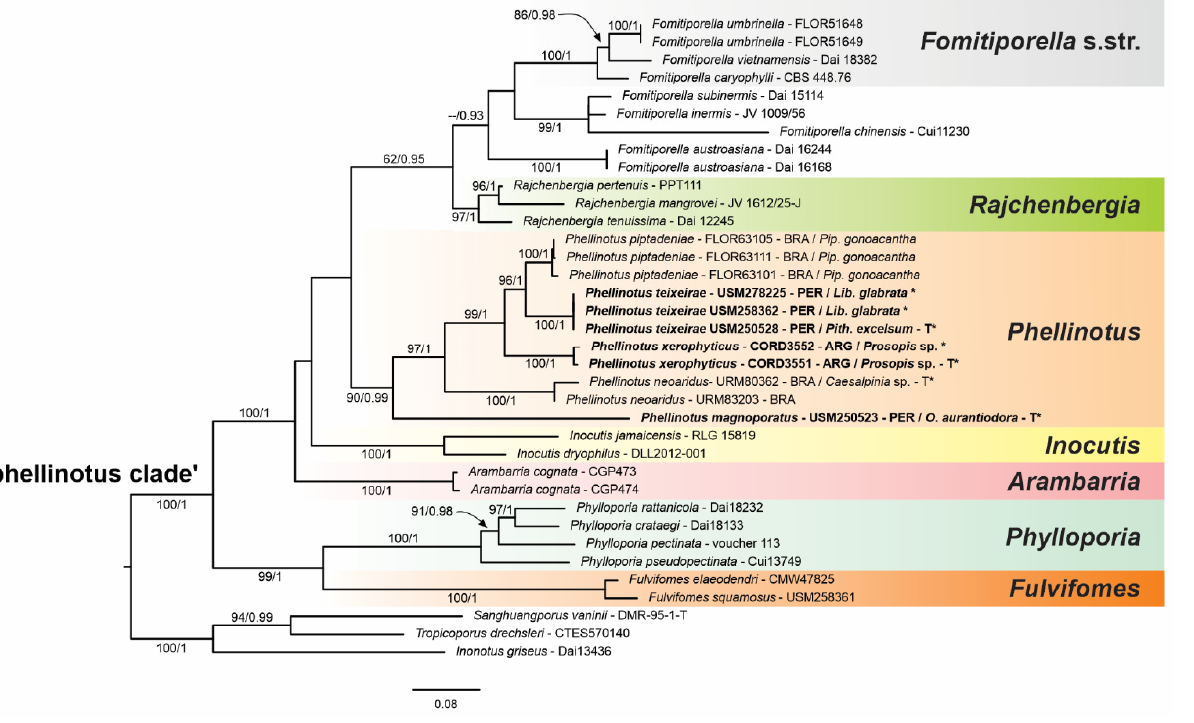
Figure 1. Maximum likelihood (ML) tree of the ‘phellinotus clade’ from the dataset of 36 combined sequences ( nLSU + nITS +TEF1- α +RPB2). Bootstrap values above 60% and Bayesian posterior probability above 0.8 are shown. Bold font is used to indicate the newly described species. Pip . = Piptadenia , Pith . = Pithecellobium , Lib . = Libidibia , O . = Ocotea , T = material type, * = specimen of local type, BRA = Brazil, ARG = Argentina, PER = Peru.